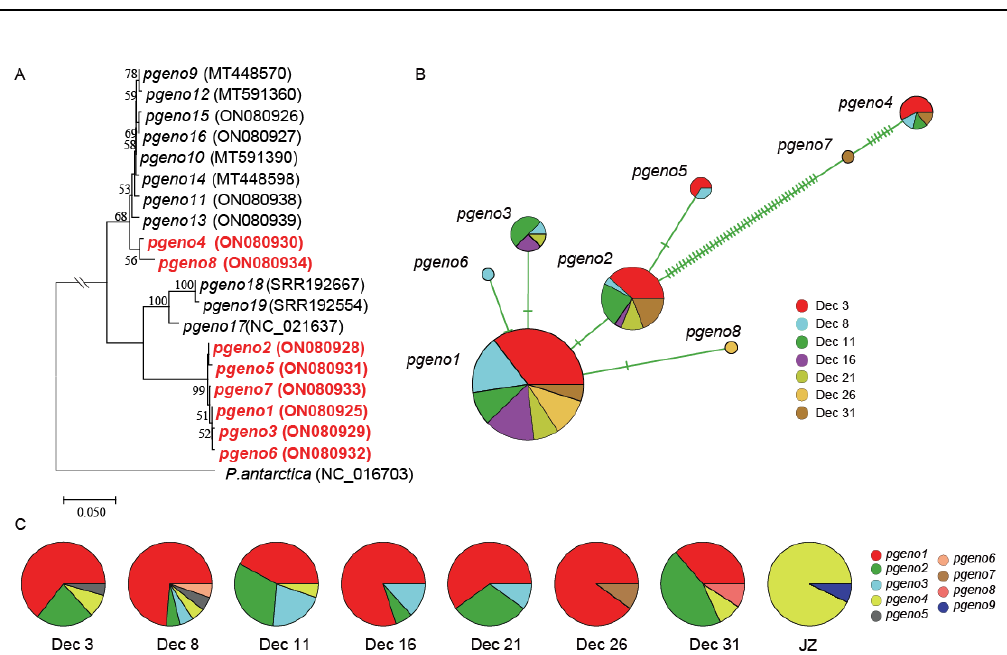
Figure 2. The phylogenetic analysis of P. globosa , genetic diversity and temporal dynamics of the P. globosa bloom using molecular marker pgcp1 . ( A ) The phylogenetic analysis based on pgcp1 non- redundant sequences, and the genotypes found in this bloom are in red. ( B ). A TCS network of the pgcp1 sequences of P. globosa that were obtained from 7 field samples. Each circle represents a different haplotype. The size of each circle is proportional to the number of sequences for each haplotype. Each line connecting two haplotypes indicates nucleotide change regardless of the length, and one bar on the lines represents one base difference. ( C ) Genotype composition of different sampling times. JZ: sample collected outsite of the Jiaozhou Bay in January 2019.